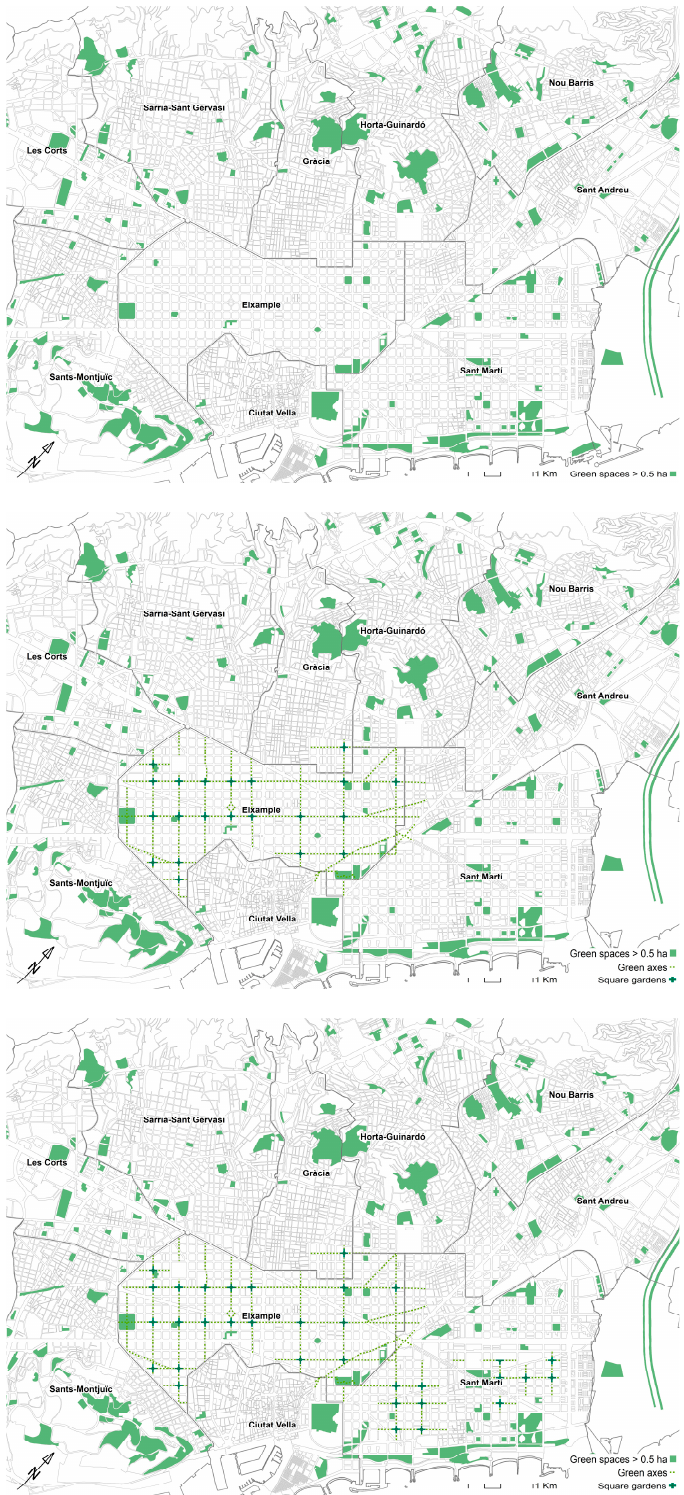
Figure 2. Barcelona districts and green spaces: ( top ) scenario 0, before the implementation of the green axes; ( middle ) scenario 1, with the green axes in L’Eixample district; and ( bo tt om ) scenario 2, with the green axes in L’Eixample and Sant Martí districts. The crossings between green axes constitute green spaces of 0.5 hectare square gardens that are highlighted in the maps. Source: the authors based on municipal data.